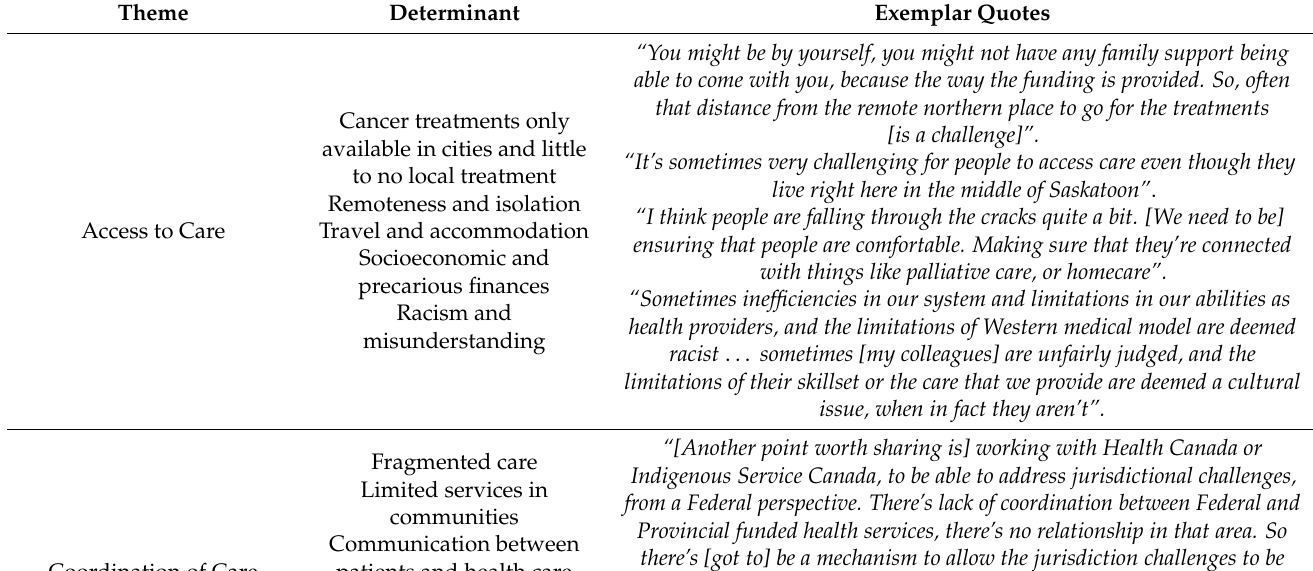
Table 1. Key Informant Perceptions of Barriers to Existing Cancer